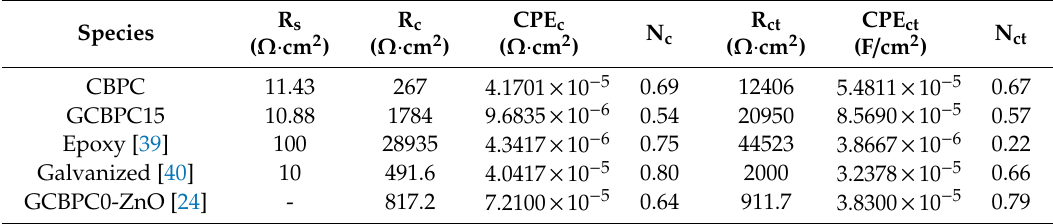
Table 7. Comparison of the EIS parameters from di ff erent